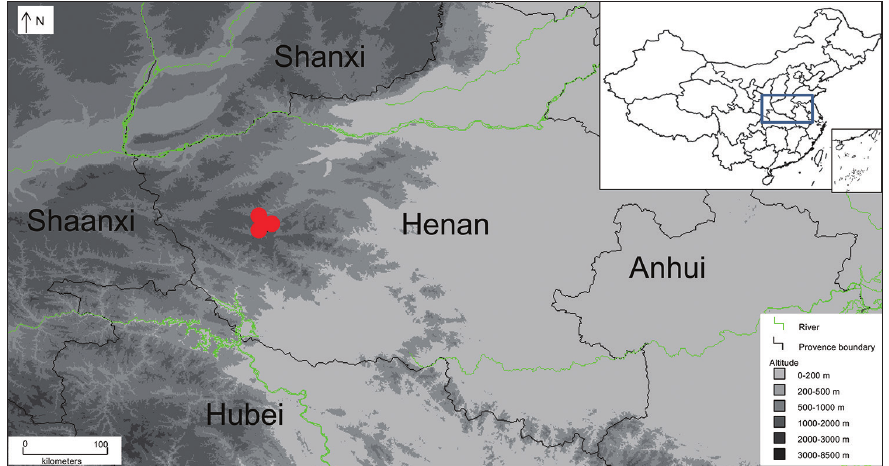
Figure 1. Map showing the collecting locations of Rana luanchuanensis sp. n. indicated by red